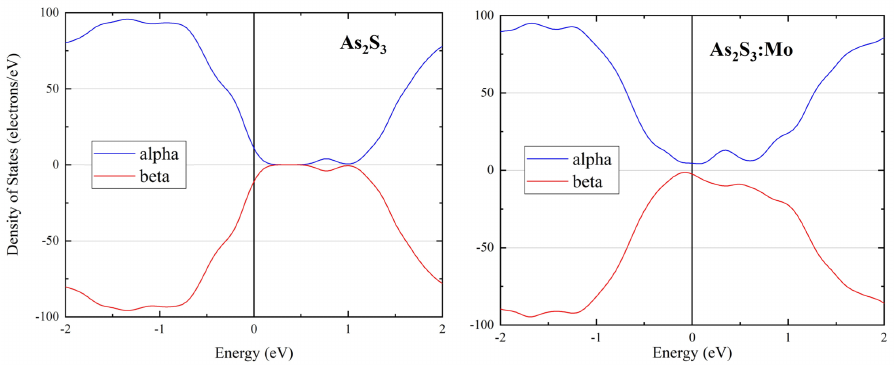
Figure 1. DOS of mq-GOpt structures of a-As 2 S 3 ( left ) and a-As 2 S 3 :Mo ( right